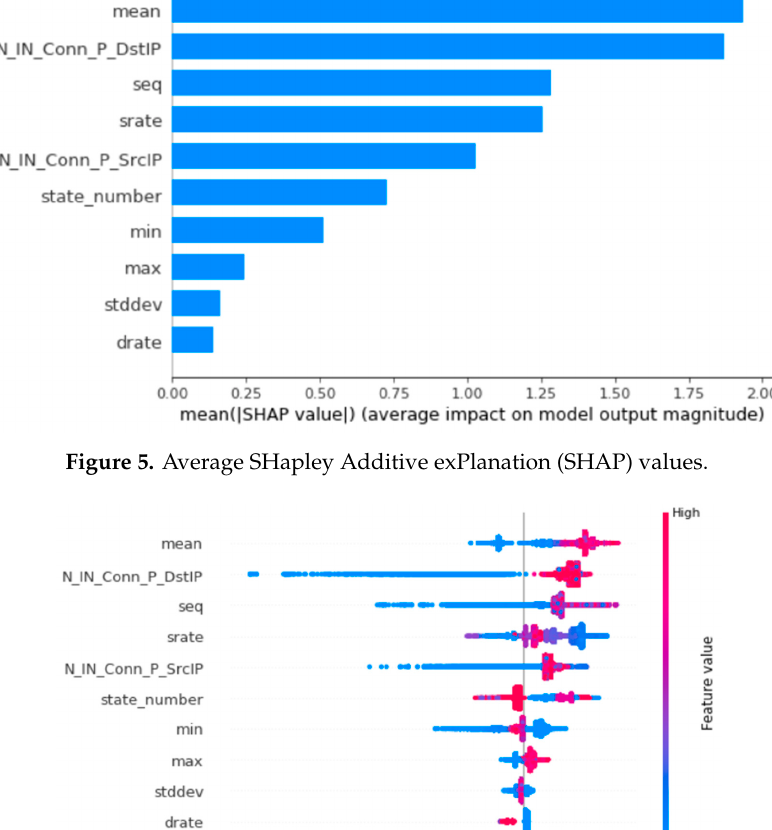
Table 5. Features Selected for Experiments.